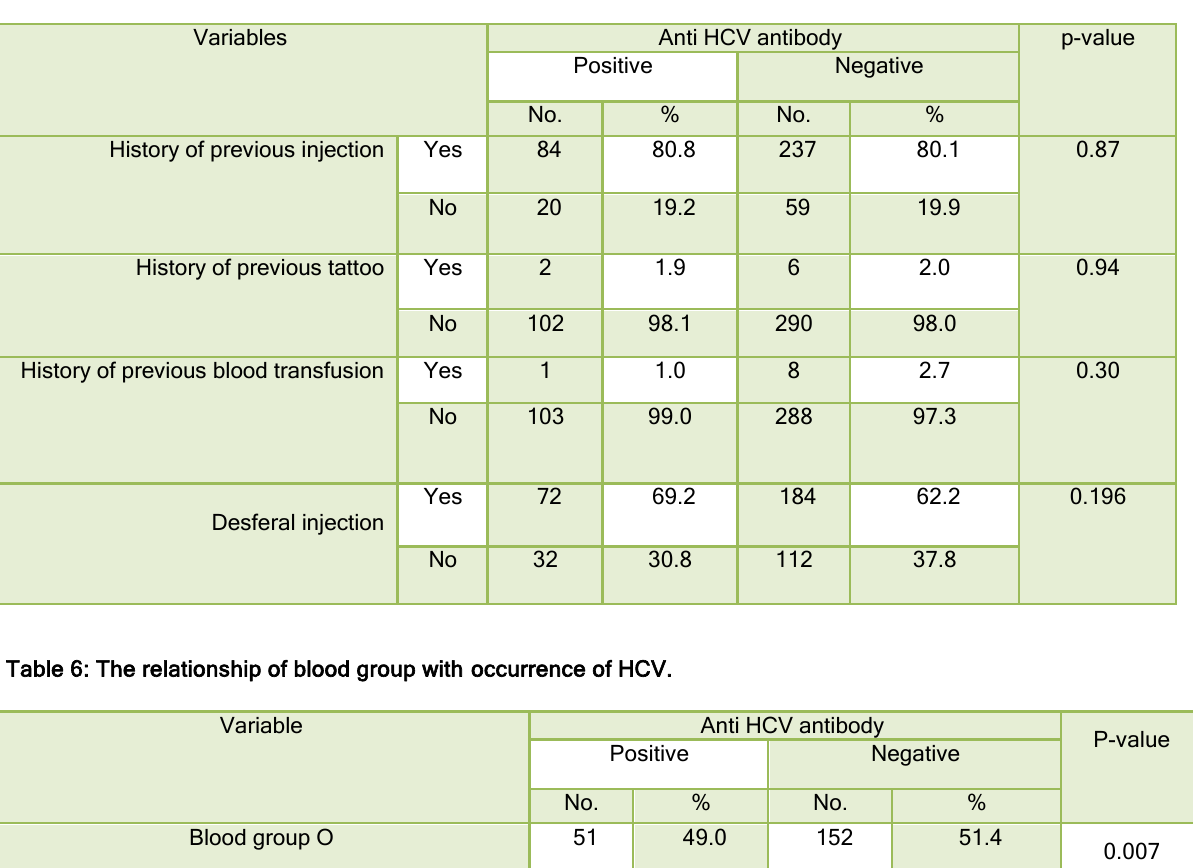
Table 5: The relationship of mode of transmission with occurrence of HCV.